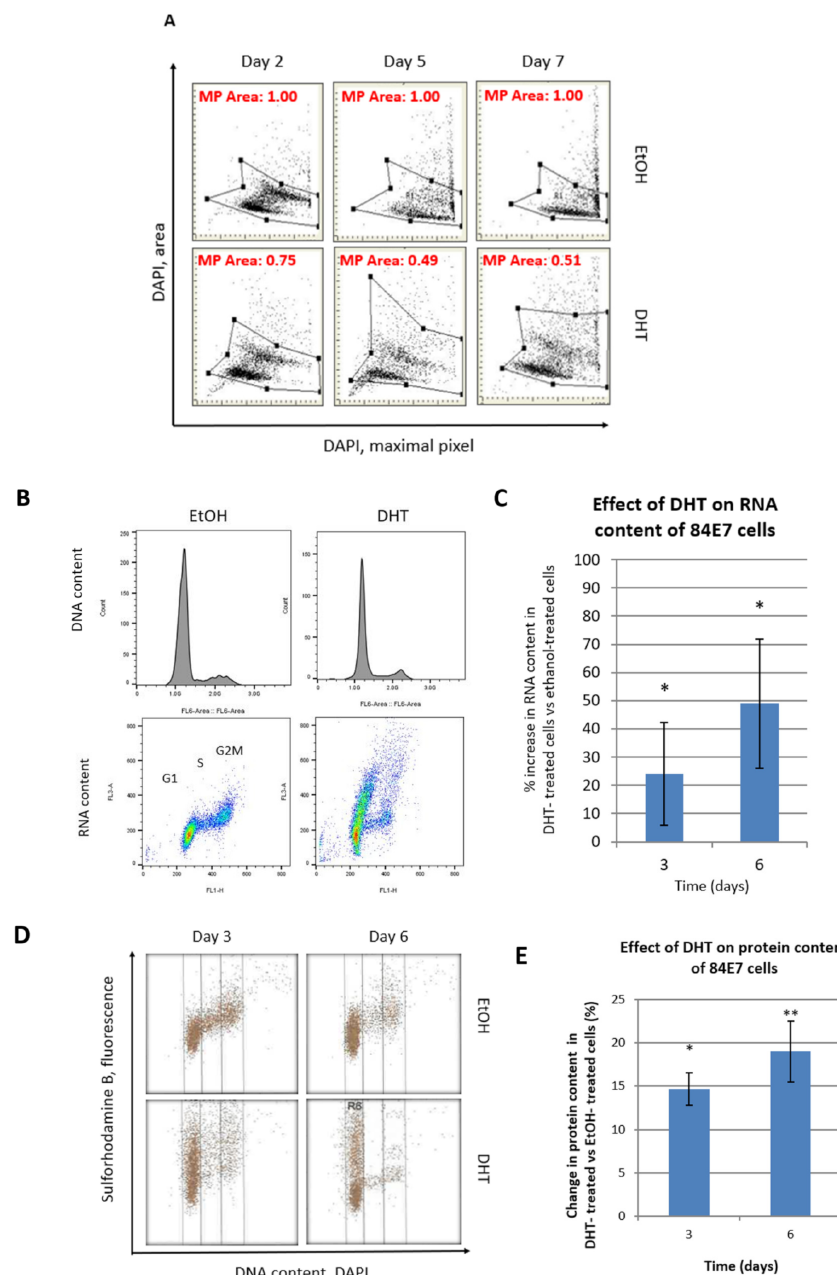
Figure 6. Effect of AR activation on 84E7 nuclear area, DNA, RNA, and protein content. ( A ) Analysis of nuclear changes, measured via laser scanning cytometry, revealed that the ratio of maximum pixels (MP) of DAPI fluorescence per nucleus to the nuclear area decreased, and indicated that the nuclear area increased as the ARs were activated for longer periods of time. ( B ) Flow cytometry demonstrated an increase in total RNA content in 84E7 cells treated with DHT on day 6, as measured via acridine orange staining. DNA histograms demonstrate G1 arrest typical for senescence. ( C ) Quantification of the flow cytometry data revealed a significant 23% and 49% increase in RNA in DHT-treated 84E7 cells over EtOH-treated controls on days 3 and 6. ( D ) Flow cytometry demonstrated an increase in total protein content in 84E7 cells treated with DHT on days 3 and 6, as measured via sulforhodamine B staining. ( E ) Quantification of the flow cytometry data revealed a significant 14.67% and 19% increase in cellular protein in DHT-treated 84E7 cells over control on day 3 and day 6, respectively (* p -value < 0.05, ** p -value <